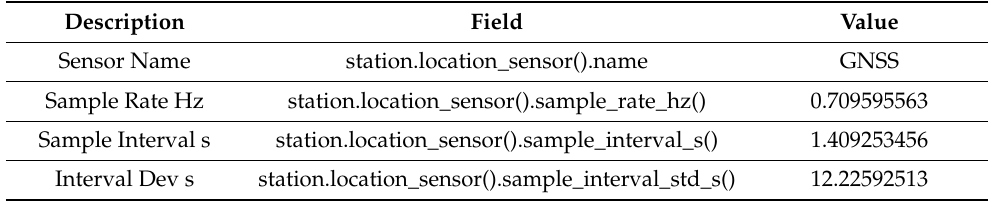
Table 10. Smartphone Location Sensor.